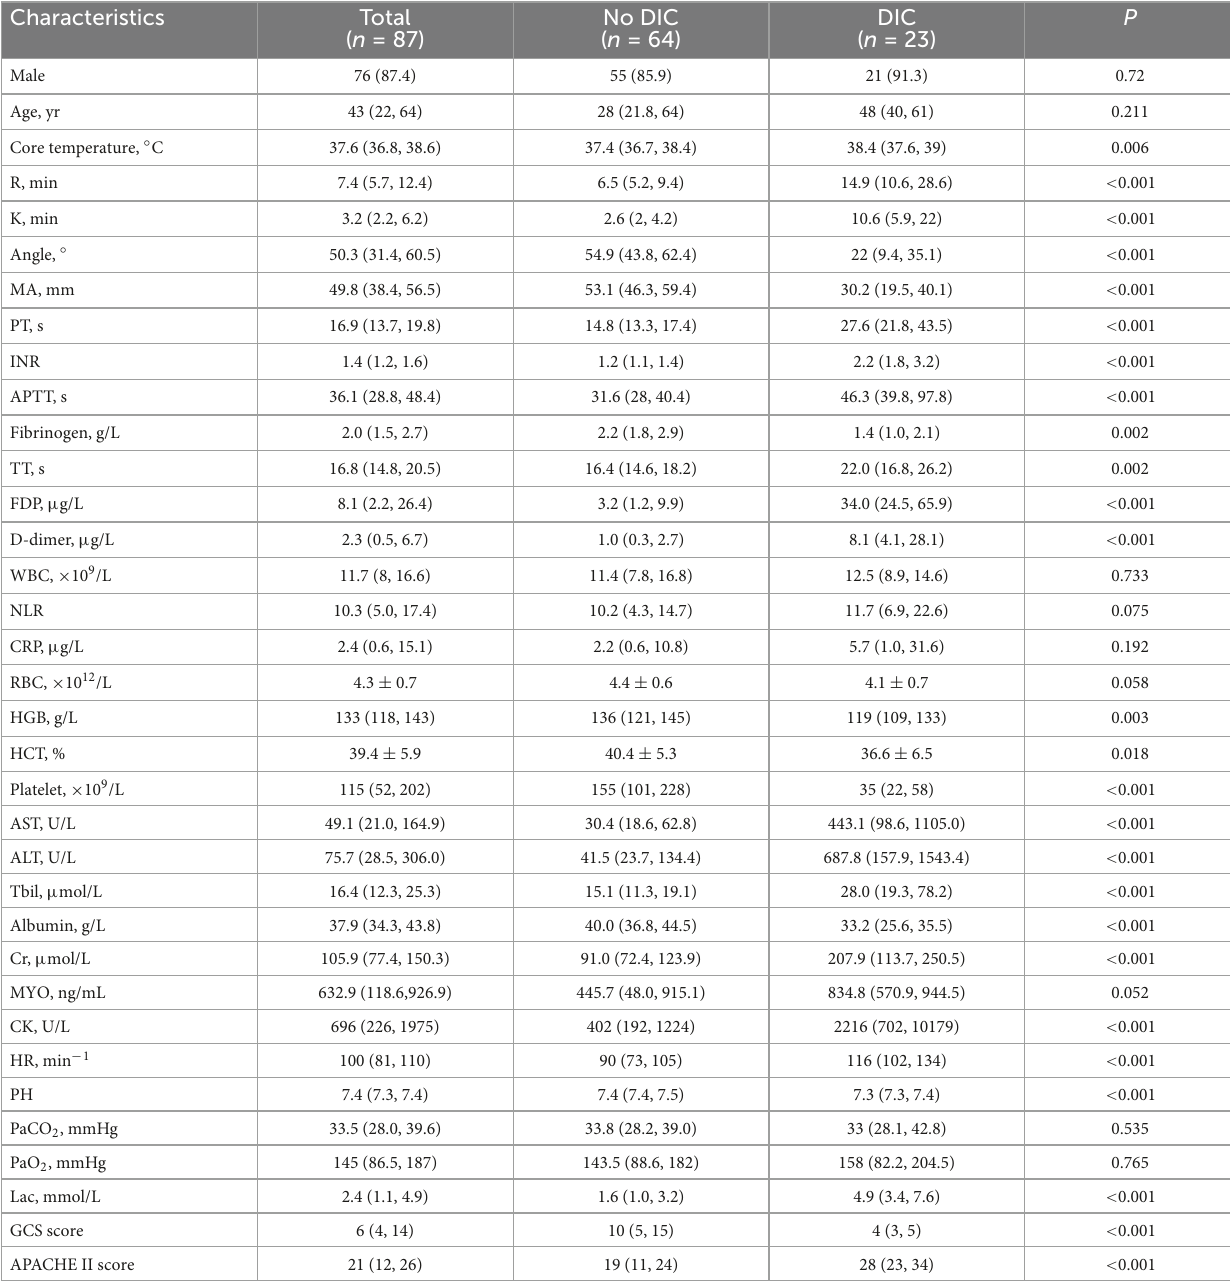
TABLE 1 Clinicodemographic characteristics of patients with heatstroke at admission to the intensive care unit, stratified by disseminated intravascular coagulation (DIC) diagnosis.